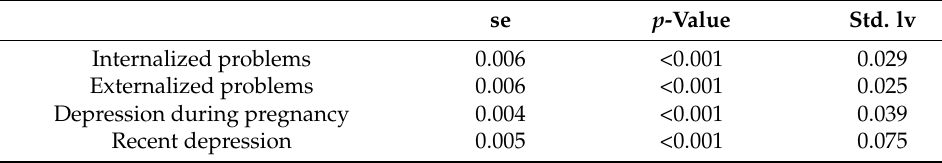
Table 8. Indirect effects through parental stress on internalized